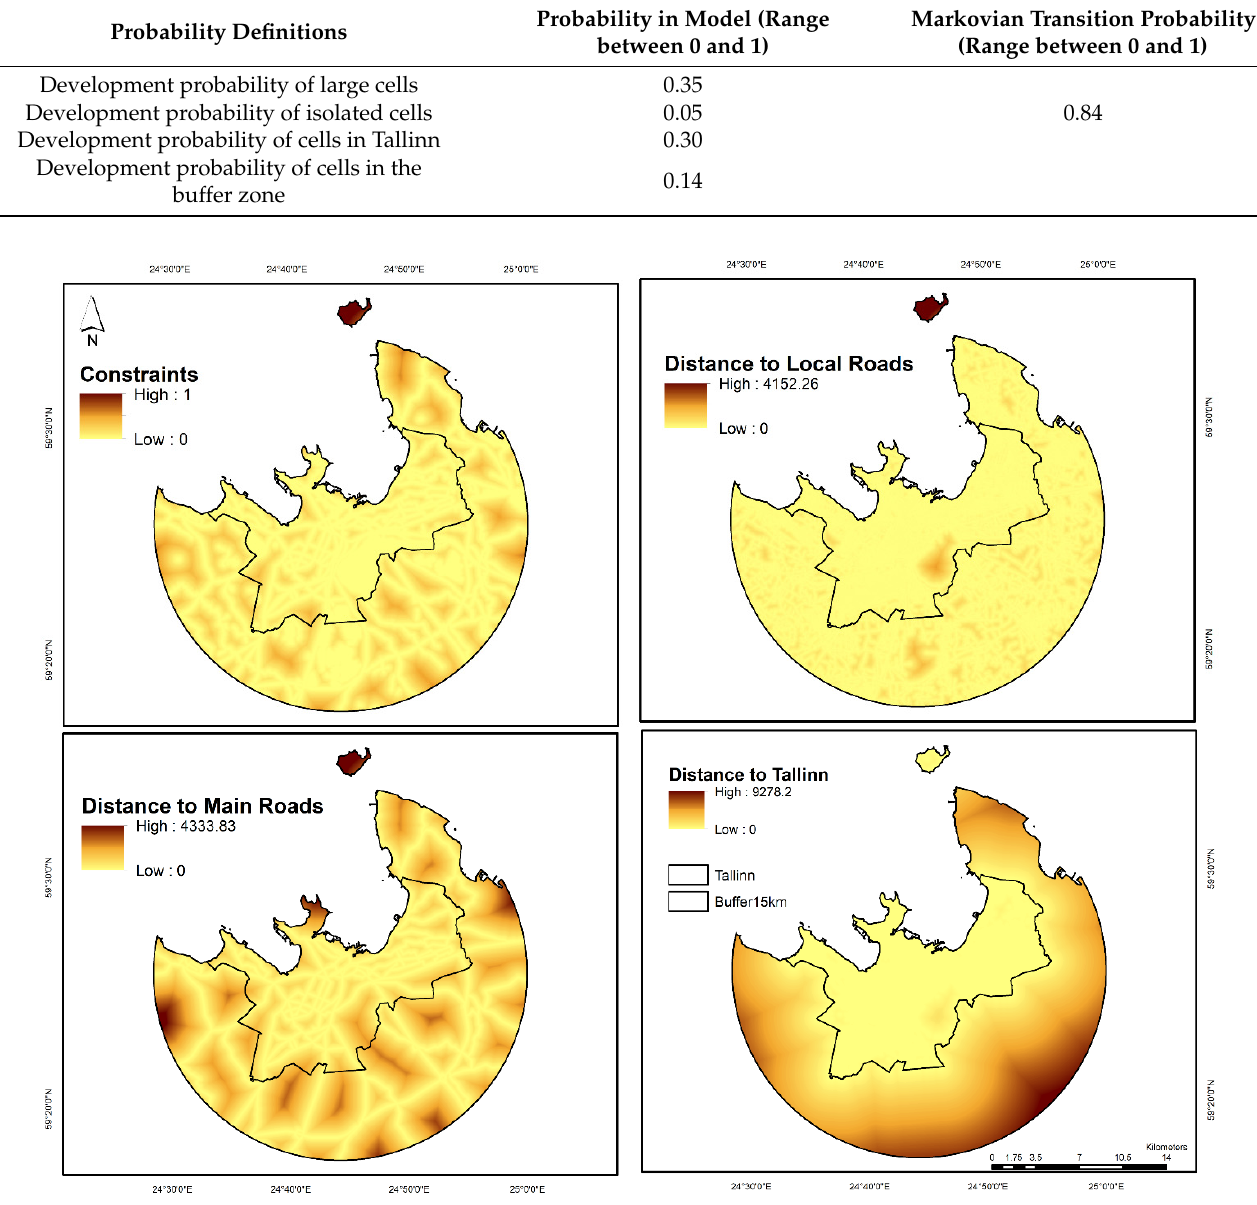
Figure 5. Constraints and accessibility factors.